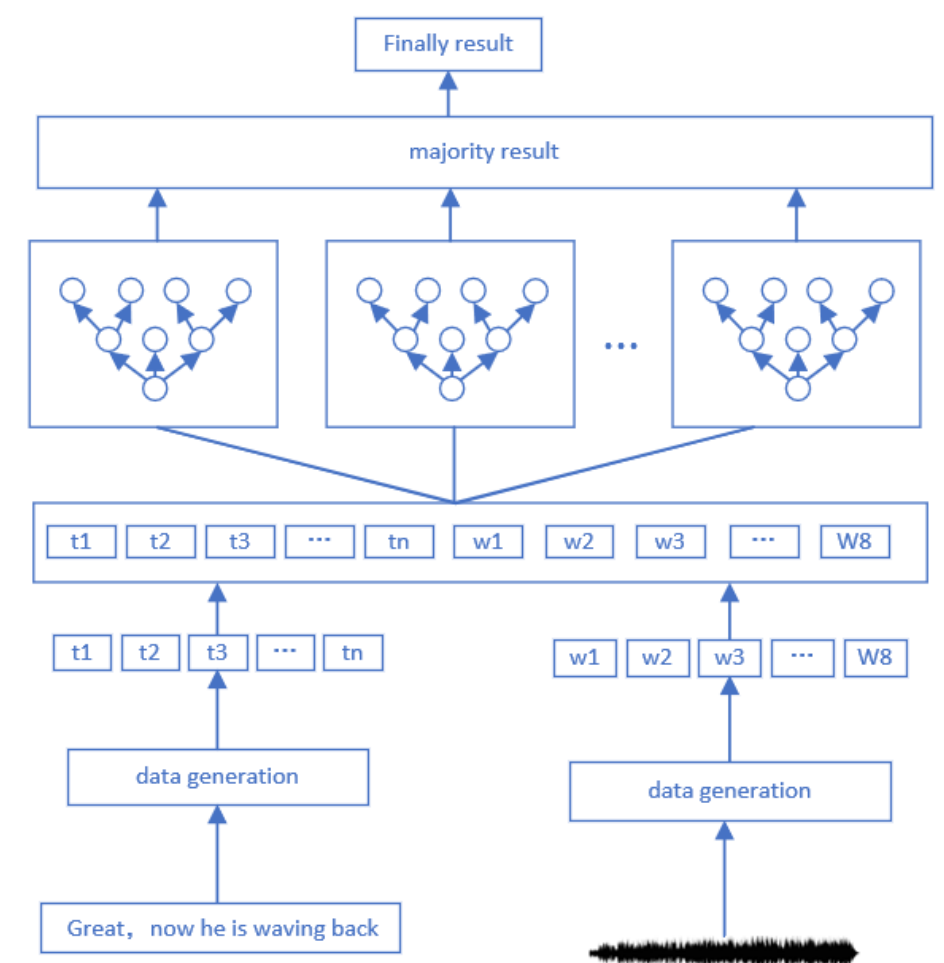
Figure 3. Multi-modal fine-grained emotion classification model based on sample disequilibrium.